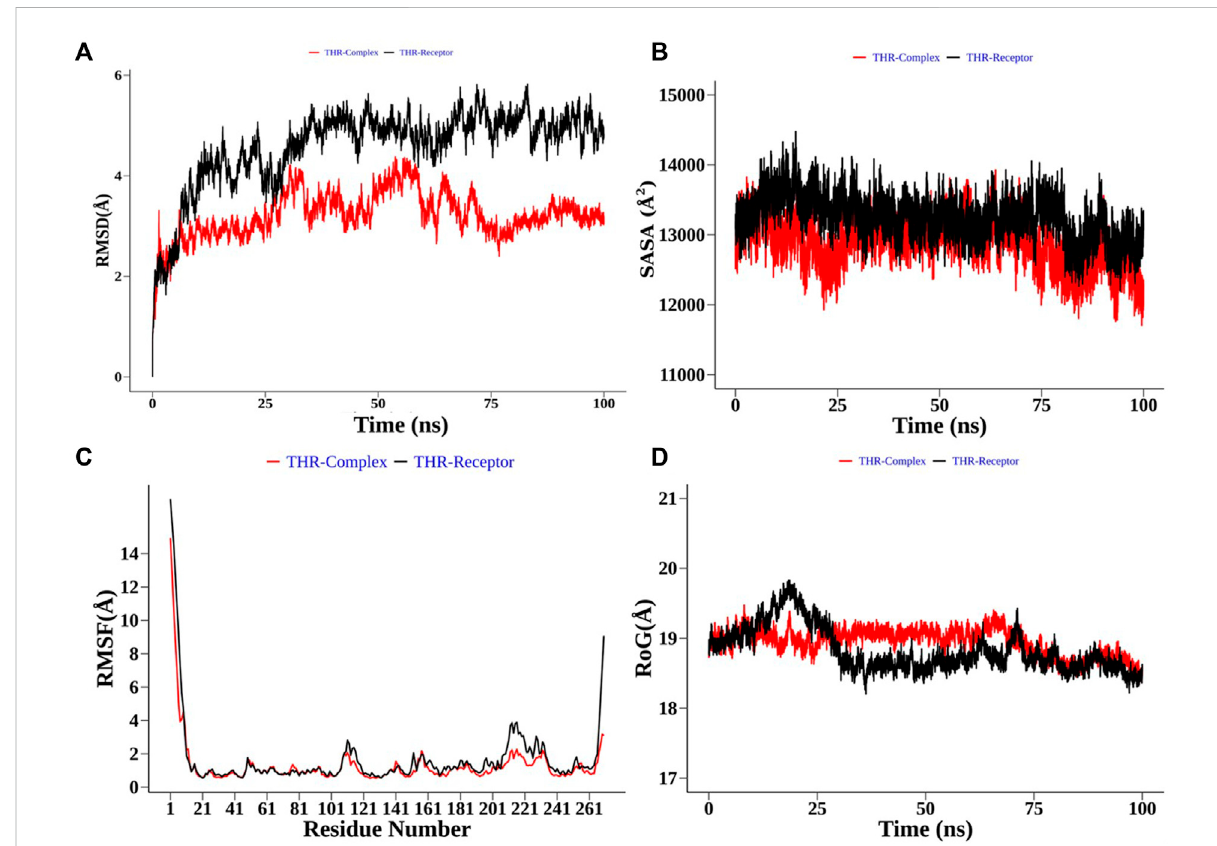
FIGURE 8 Structural order parameter analysis of the THR complex (curcumin) with respect to the THR receptor. (A) Root mean square deviation (RMSD), (B) solvent-accessible surface area (SASA), (C) root mean square fl uctuation (RMSF), and (D) radius of gyration (RoG)